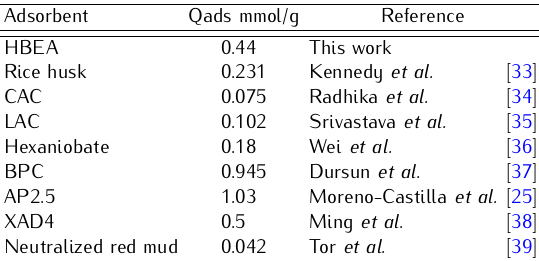
Figure 9. Effect of regeneration by methanol of HBEA zeolite after adsorption of PhOH: ( (cid:3) ) fresh zeolite, ( (cid:77) ) after one cycle, (O) after five cycles. Table 4. Adsorption capacity for the adsorption of phenols on various adsorbents collected from